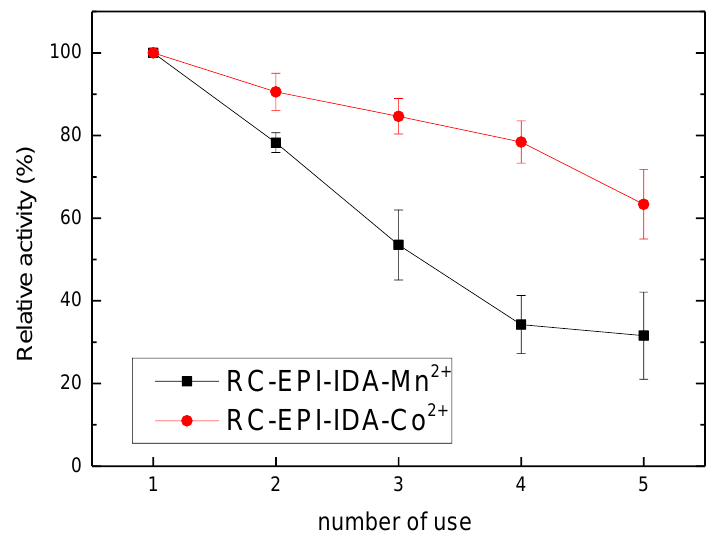
2+ and IMAM-Mn 2+